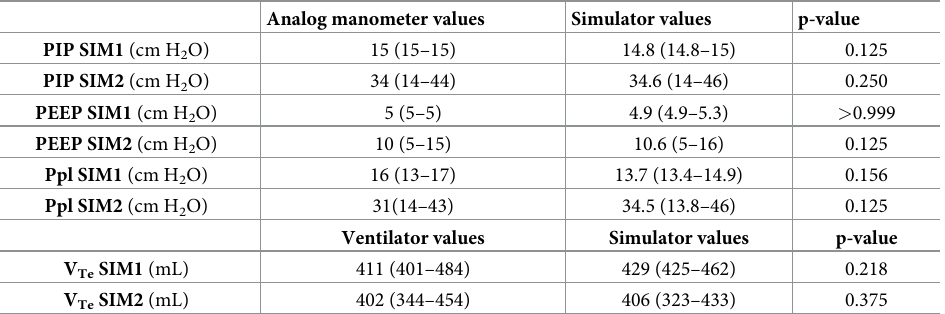
PEEP = positive end-expiratory pressure, PIP = peak inspiratory pressure, Ppl = plateau pressure, SIM1 =